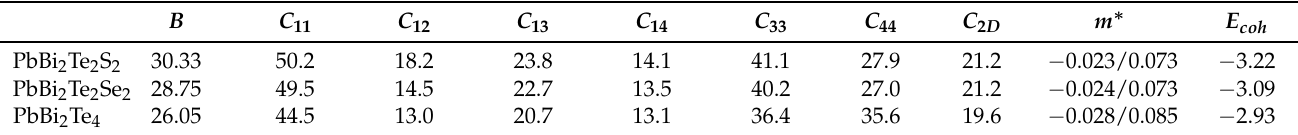
Figure 2. Electronic band structures of PbBi 2 Te 2 S 2 ( a ), PbBi 2 Te 2 Se 2 ( b ), PbBi 2 Te 4 ( c ) and correspond- ing total (light yellow background) and partial (color lines) DOS ( d ) calculated with the WC-GGA functional and SOC. Table 2. Bulk modulus B (GPa), bulk elastic constants C ij (GPa), two-dimensional elastic constant C 2 D (N/m), effective mass m ∗ ( m e ) of electrons/holes, cohesive energy E coh (eV/at.) at 0 K, calculated with the WC–GGA functional. (Note: The column corresponding to the deformation potential constants has been